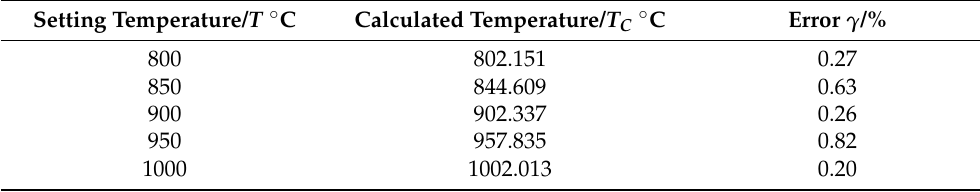
Table 3. Comparison of the calculated temperature with those of the blackbody furnace.